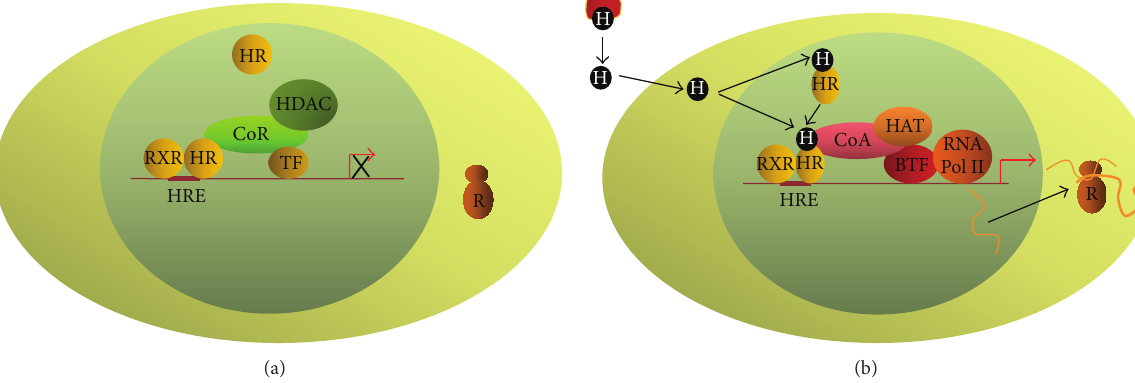
Figure 4: Diagram of type II receptor genomic mode of action. (a) In the absence of the hormone, the receptor binds to HRE as heterodimer with 9- cis -retinoic acid receptor. The hormone-free receptor recruits a corepressor complex possessing a histone deacetylase activity. Deacetylation of histones results in chromatin condensation and in transcription inhibition. (b) In the circulation, the hormone forms complexes with transporting proteins. The hormone enters the cell by diffusion or is actively transported by specific cell membrane proteins. The majority of type II receptors reside in the nucleus. Upon hormone binding, the receptor changes its conformation, which results in the dissociation of the corepressor complex and in the binding of the coactivator complex. Histone acetylation by HDAC results in chromatin decondensation, which promotes transcription factor binding to DNA and transcription activation. H: hormone, RH: nuclear hormone receptor, RXR: 9- cis- retinoic acid receptor, HRE: hormone response element, CoA: coactivator complex, HAT: histone actyltransferase, CoR: corepressor complex, HDAC: histone deacetylase, TF: transcription factor, BTF: basal transcription factors, RNA Pol II: type II RNA polymerase, and R: